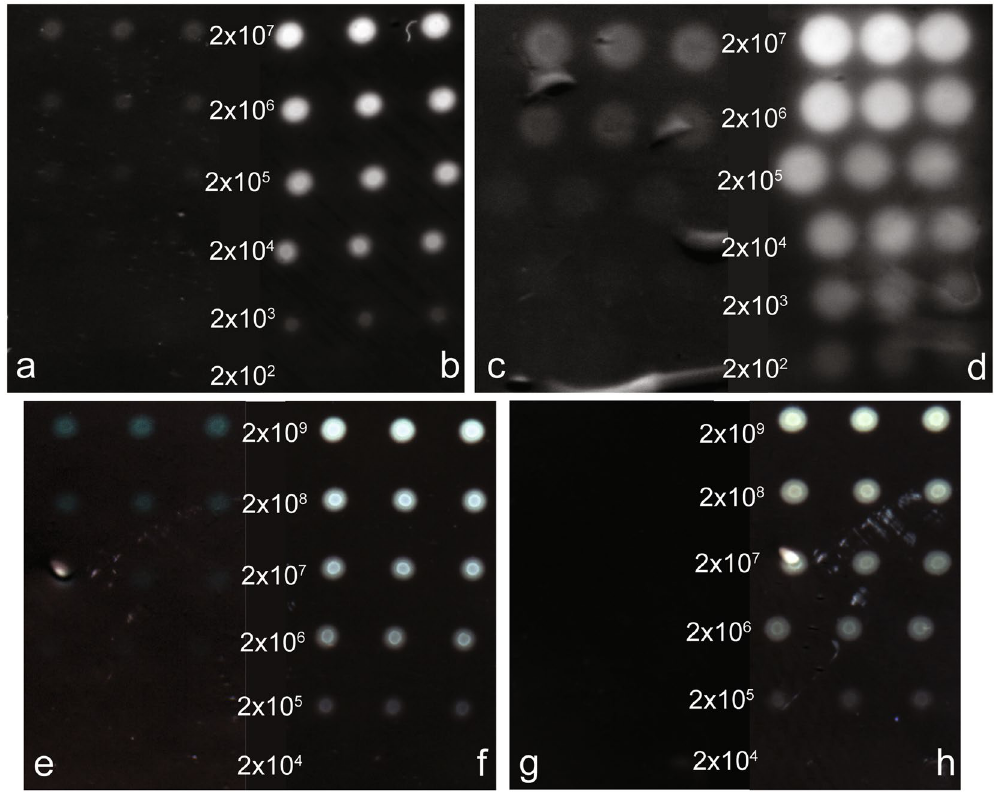
Figure 2. Vertical flow arrays for detection of protein G. Each concentration of protein G was printed in triplicate. ( a ) IgG-AuNPs detection prior to enhancement. ( b ) IgG-AuNPs detection after enhancement. (c ) IgG-AgNPs detection prior to enhancement. ( d ) IgG-AgNPs detection after enhancement. ( e ) IgG-IONPs detection prior to enhancement. ( f ) IgG-IONPs detection after enhancement. ( g ) IgG-SiNPs detection prior to enhancement. ( h ) IgG-SiNPs detection after enhancement. Middle column refers to the number of Protein G molecules per spot. Approximately ¼ of the expected radius of the spot was considered for imaging analysis and protein